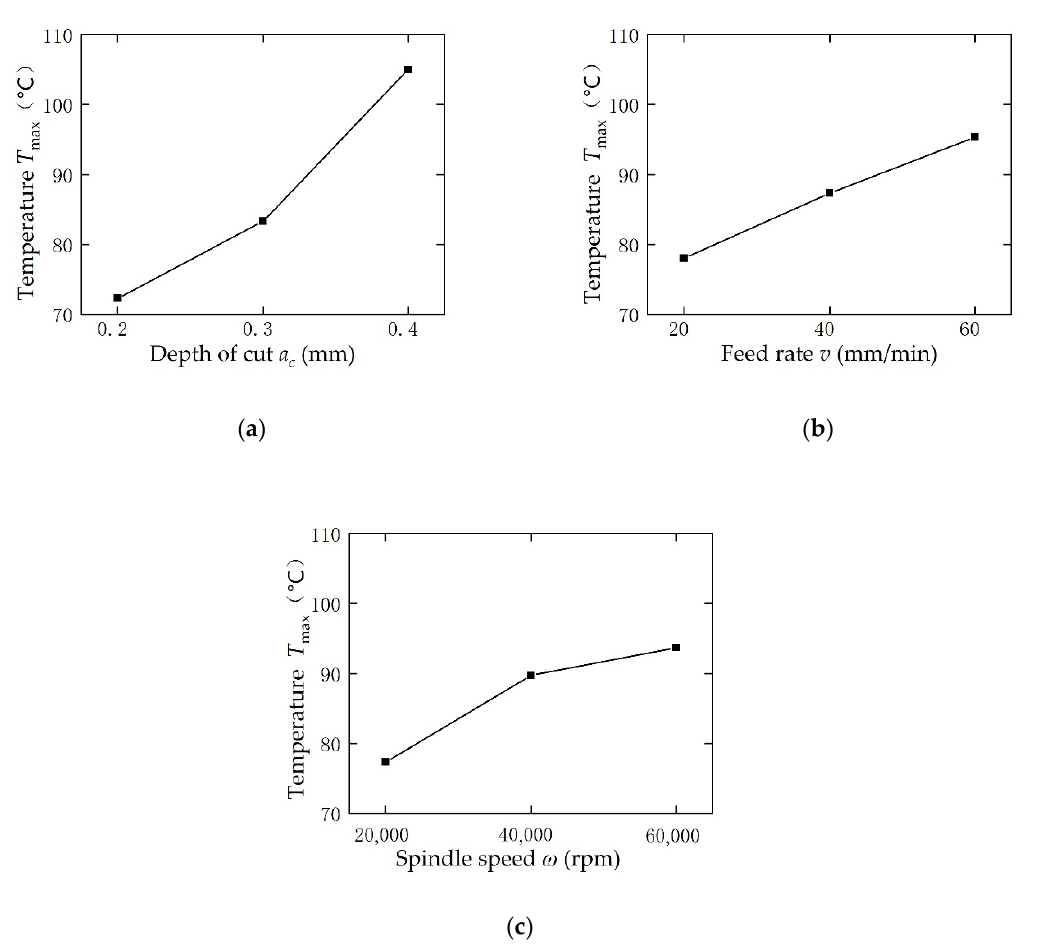
Figure 9. Variation of the bone grinding temperature with a variation of process parameters.